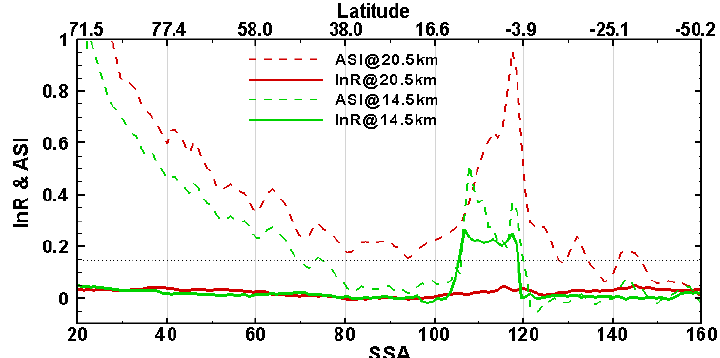
Figure 4. lnR (solid line) and ASI (dashed line) plotted as a function of single-scattering angle (SSA) at 14.5km (green) and 20.5km (red). This figure uses OMPS/LP observations taken on 19 June 2014, from the same orbit shown in Fig. 3. The dotted black line represents the value of the cloud detection threshold for the lnR